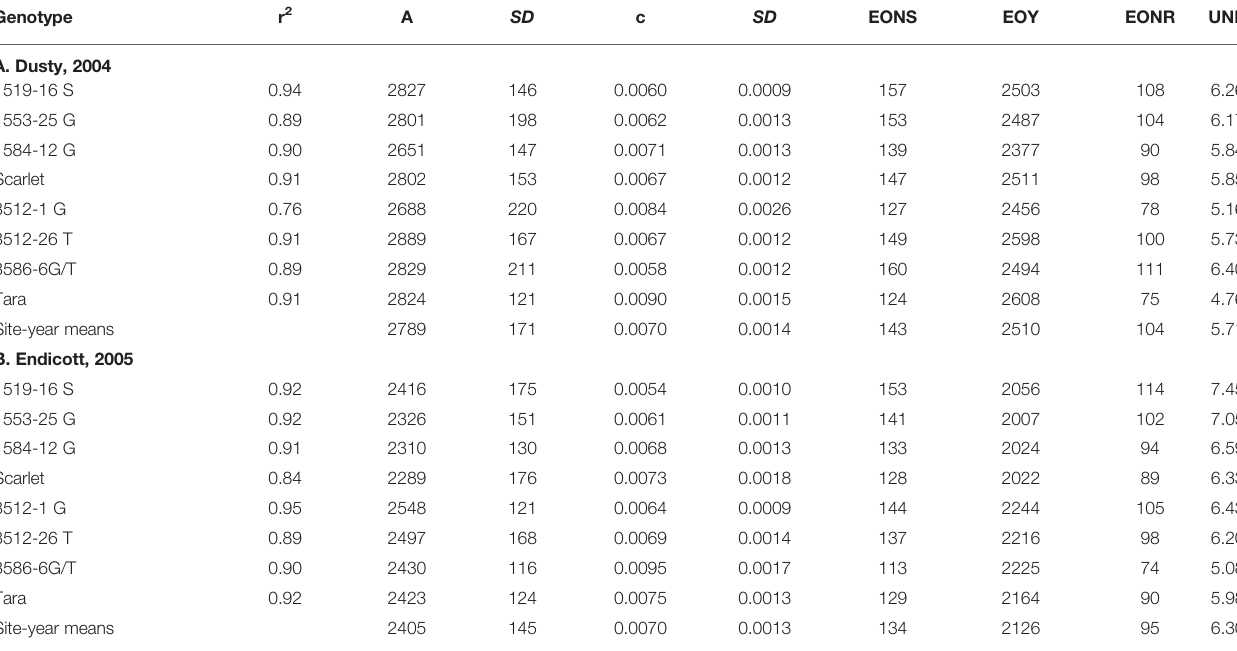
TABLE 1 | Mitscherlich model correlation coef fi cients, A and c parameters with their standard errors for yield response to N supply of all genotypes, shown in Figures 1 and 2 . Genotype